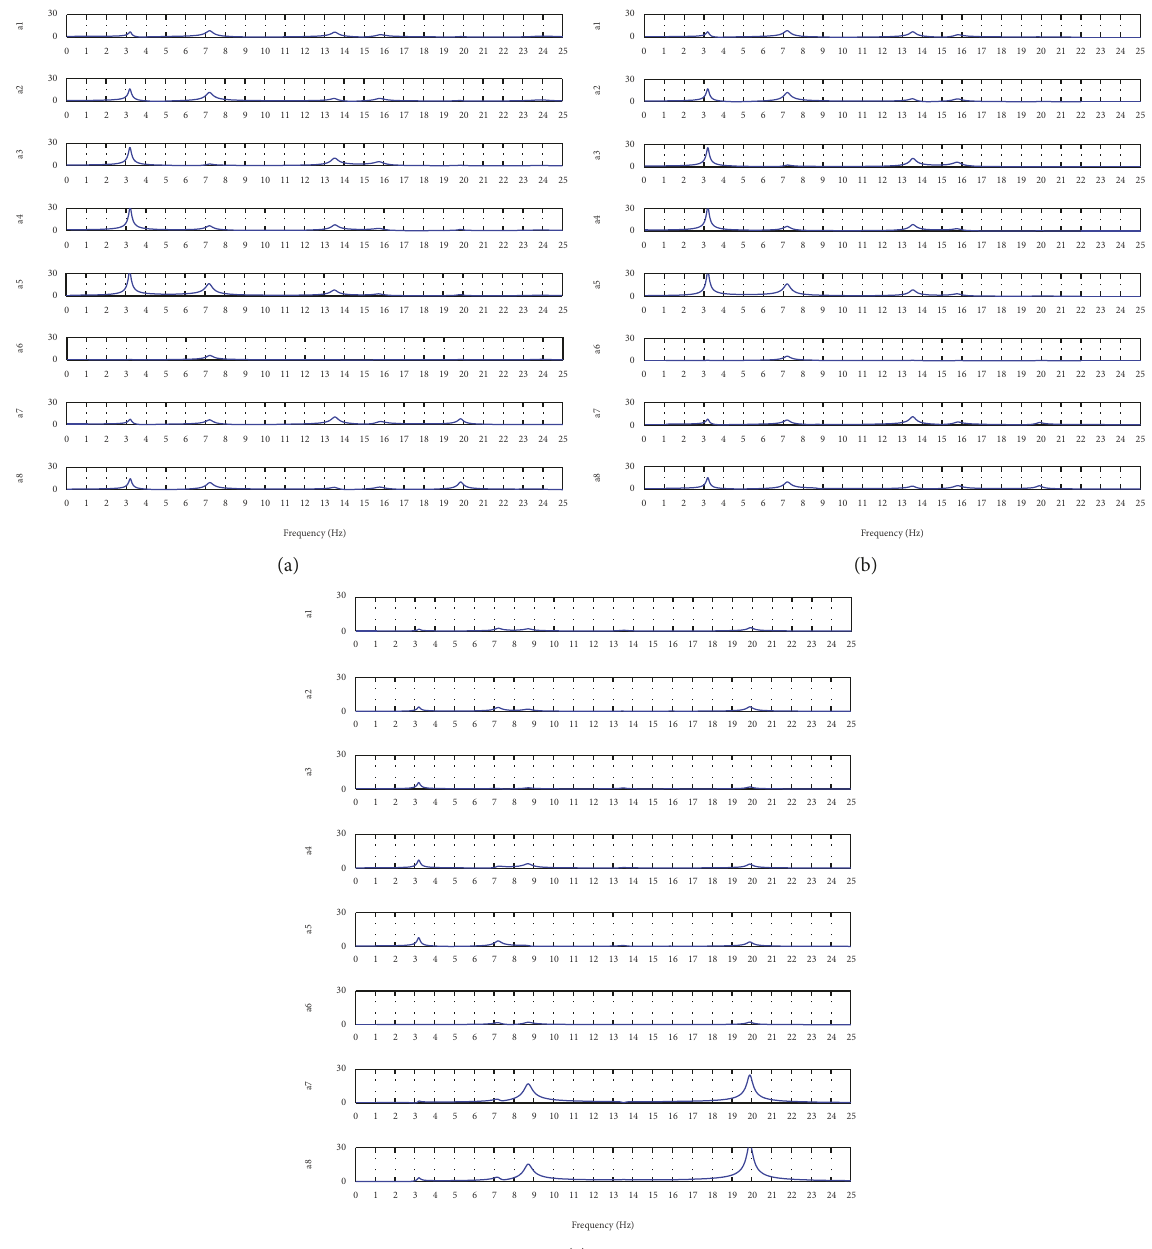
Figure 7: Rigid connected (RC) configuration, identified frequency response functions. Ground acceleration 𝑥 direction, (a) 𝐻 𝑥 ; 𝑥 - 𝑦 directions, (b) 𝐻 𝑥 , and (c) 𝐻 𝑦 . White noise test PGA 0.05